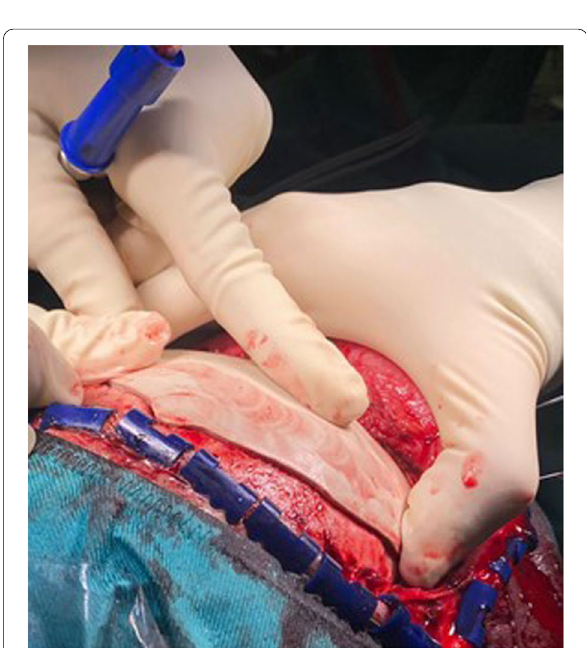
Fig. 2 Intraoperatory view of case 5: the fitting problem is evident on the bone-implant inlay interface which creates an impingement that prevents the correct position